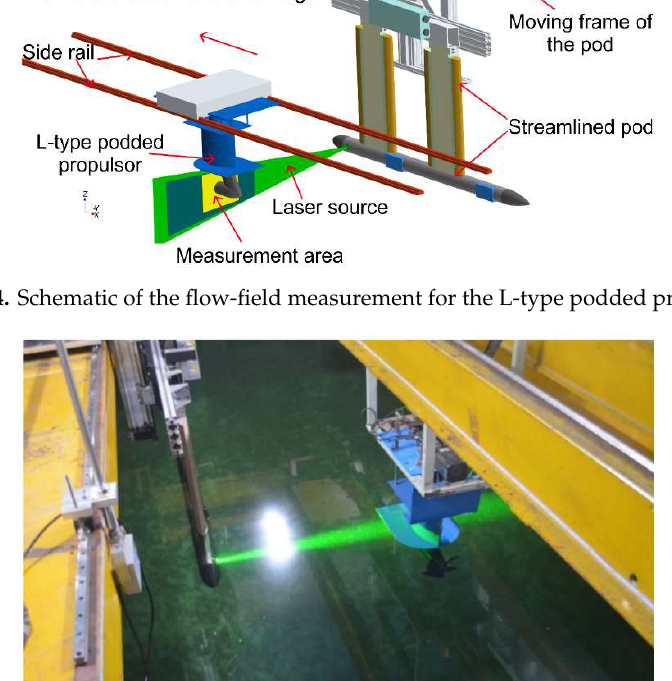
( b ) Figure 3. Flow-field cross-sections for the L-type podded propulsor ( a ) Drawings of three measured cross-sections ( b ) Positions of three measured cross-sections. Before measuring the flow field of the L-type podded propeller, the position of the PIV system was adjusted, so that the laser could accurately irradiate the cross-sections that are to be measured.